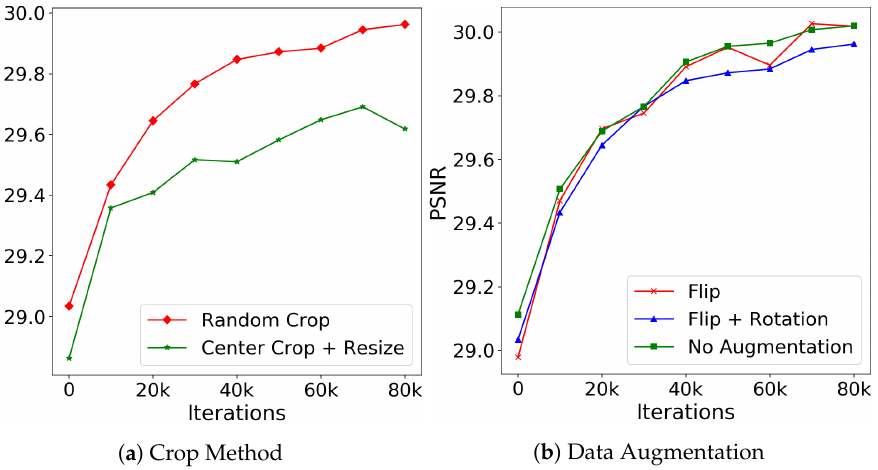
Figure 5. Training with different processing strategies. ( a ) Illustrates the difference between ran- dom and center crop accompanied with resizing. ( b ) The validation curves using different data augmentation methods. All the models are trained on CelebA [33] with σ =